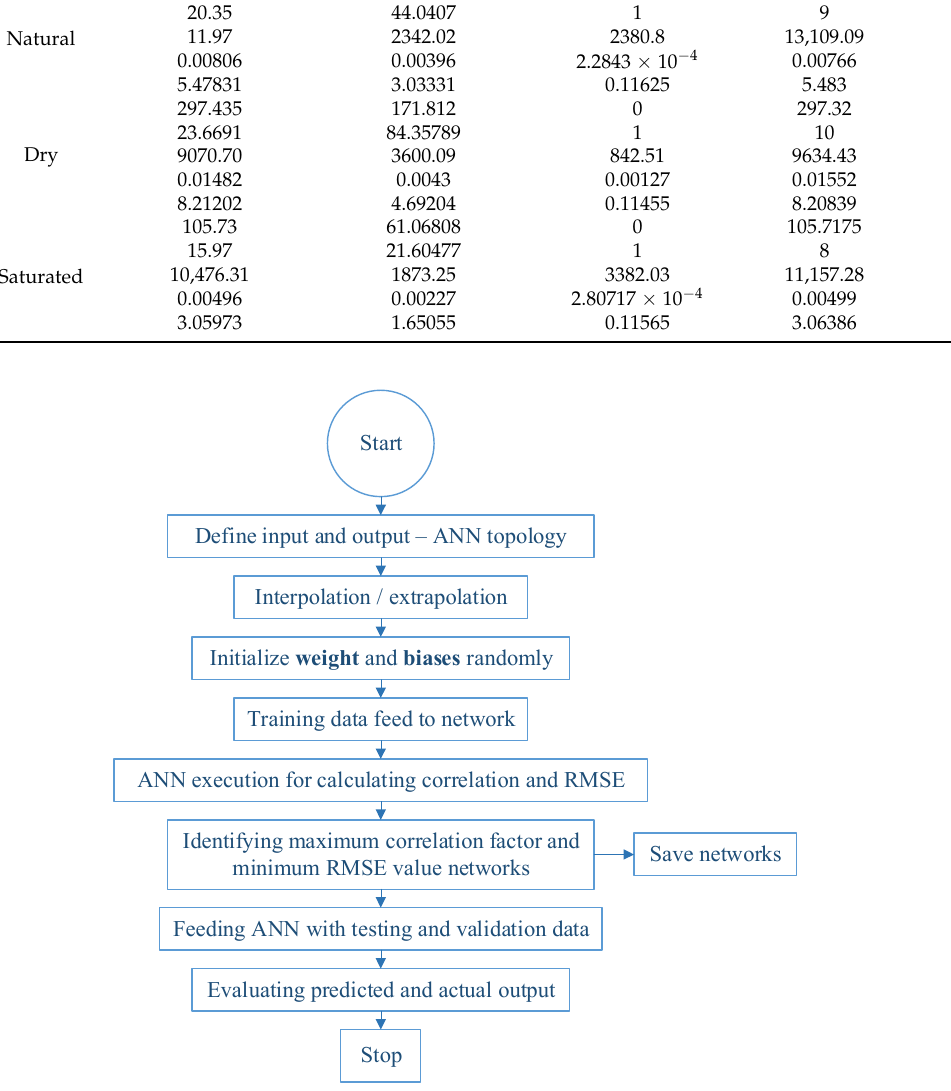
Figure 17. Flow chart of data processing by ANN model.